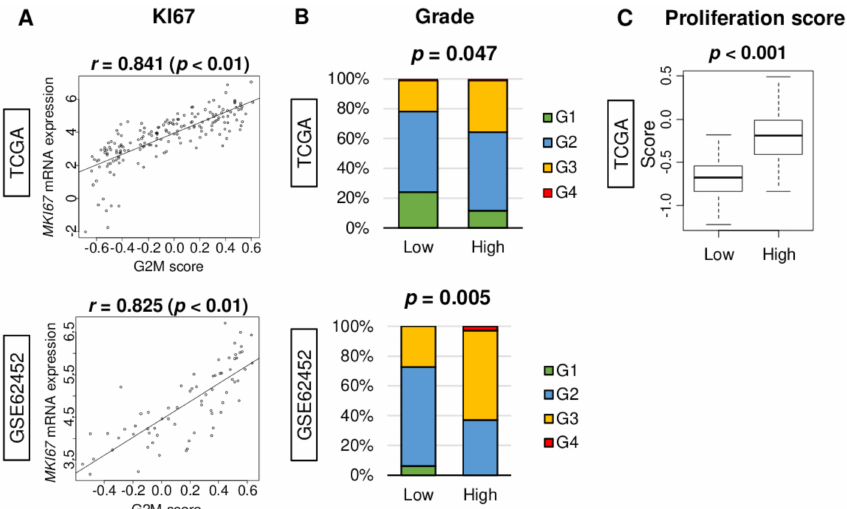
Figure 2. Association of G2M pathway score with clinical parameters of cancer cell proliferation in TCGA and GSE62452 cohorts. ( A ) Correlation between the G2M score and MKI67 expression in both cohorts. p- value was analyzed with spearman r correlation. ( B ) Bar plots of the G2M score high and low groups demonstrate distribution of pathological grade: Grade 1 (G1, green), Grade 2 (G2, blue), Grade 3 (G3, yellow), and Grade 4 (G4, red) in the TCGA and GSE62452 cohorts. ( C ) Boxplot of proliferation score by low and high G2M score group in the TCGA cohort. High and low score groups were divided by the median value. Tukey-type boxplots show median and inter-quartile level values, and the analysis of variance (ANOVA) test is used to calculate p-